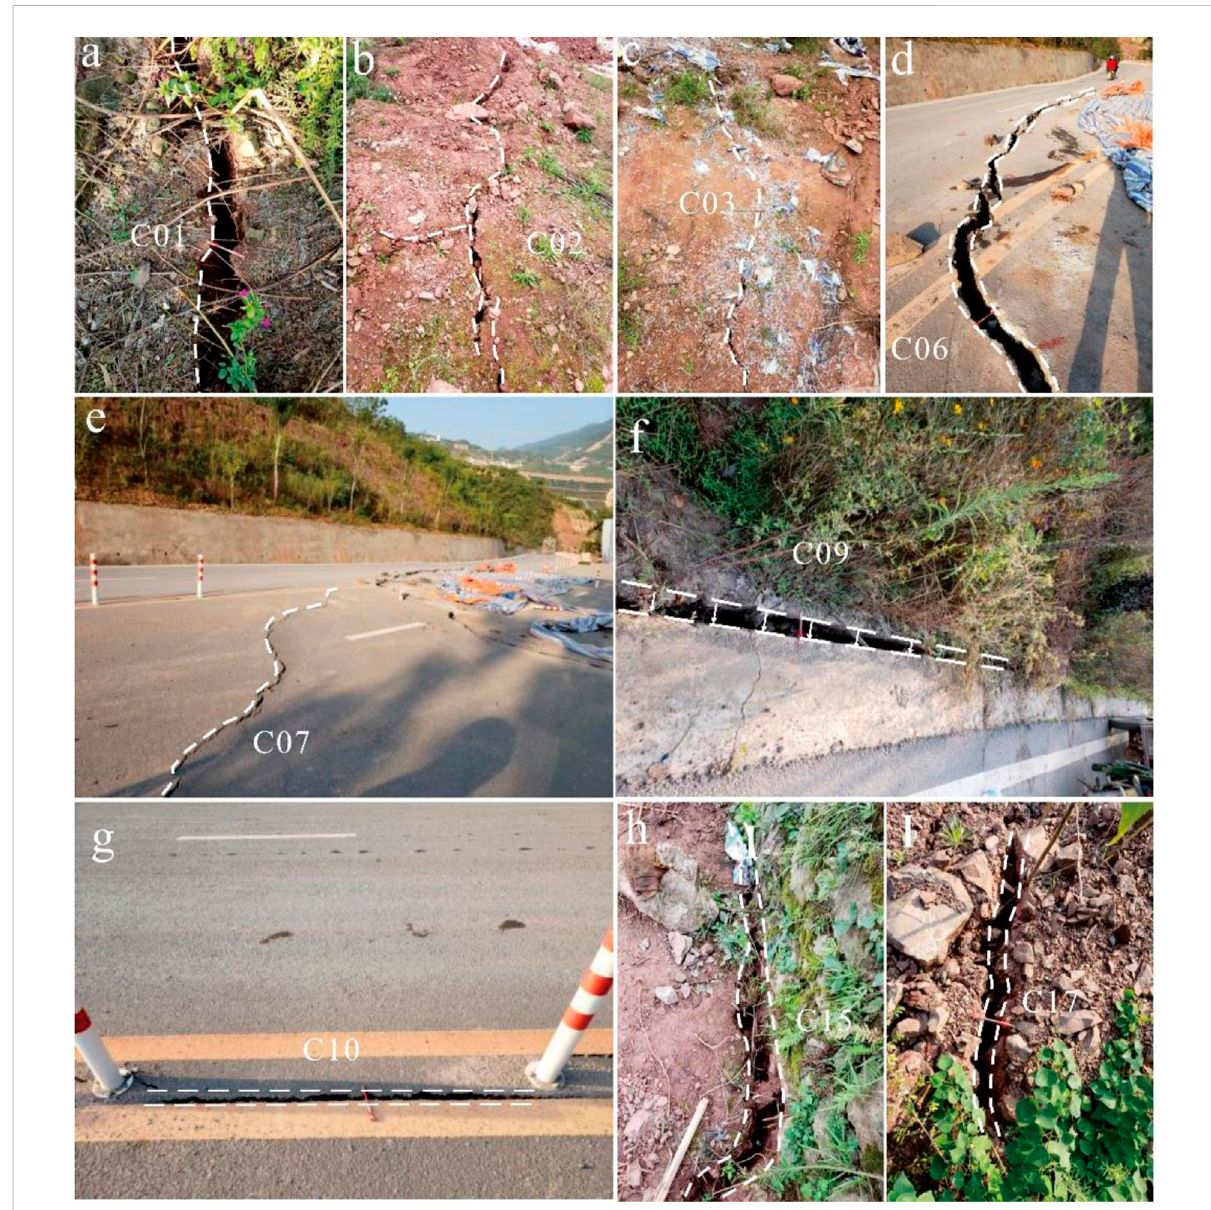
FIGURE 7 NewdeformationsignsoftheDashuitian landslide. (A,B) aretensilecrackslocated attherearpart; (C – E) areshearcrackslocated attheeastern edge; (F,G) are large tensile cracks develop along Ring Road at the middle-rear part; (H,I) are tensile cracks located at the leading